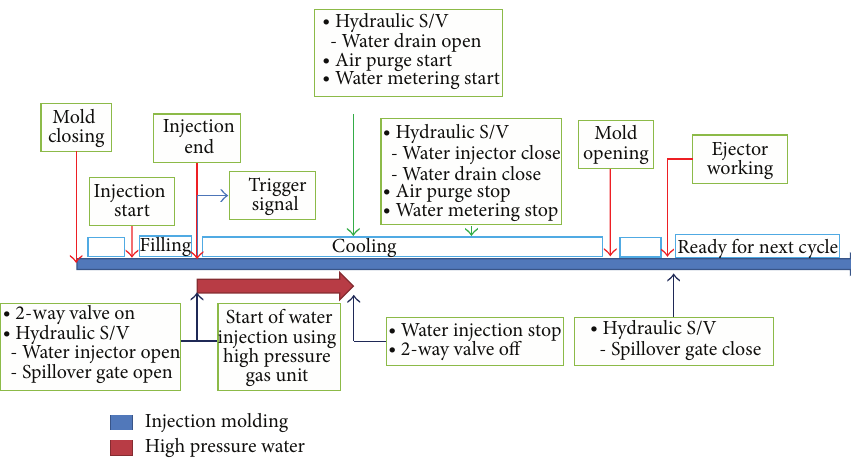
Figure 6: Sequence of steps in the GAIM-based WAIM